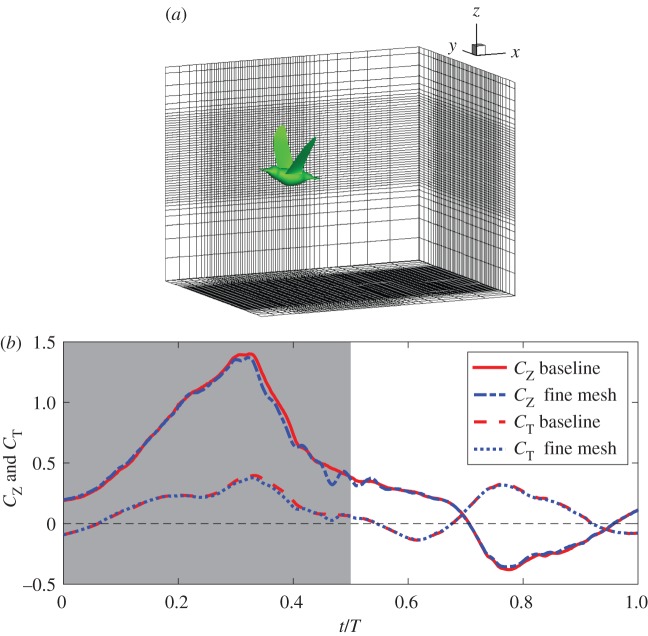
(a) Baseline mesh around the bird (only one out of every 12 points in each direction is shown). (b) Force comparison between baseline simulation and fine mesh simulation.